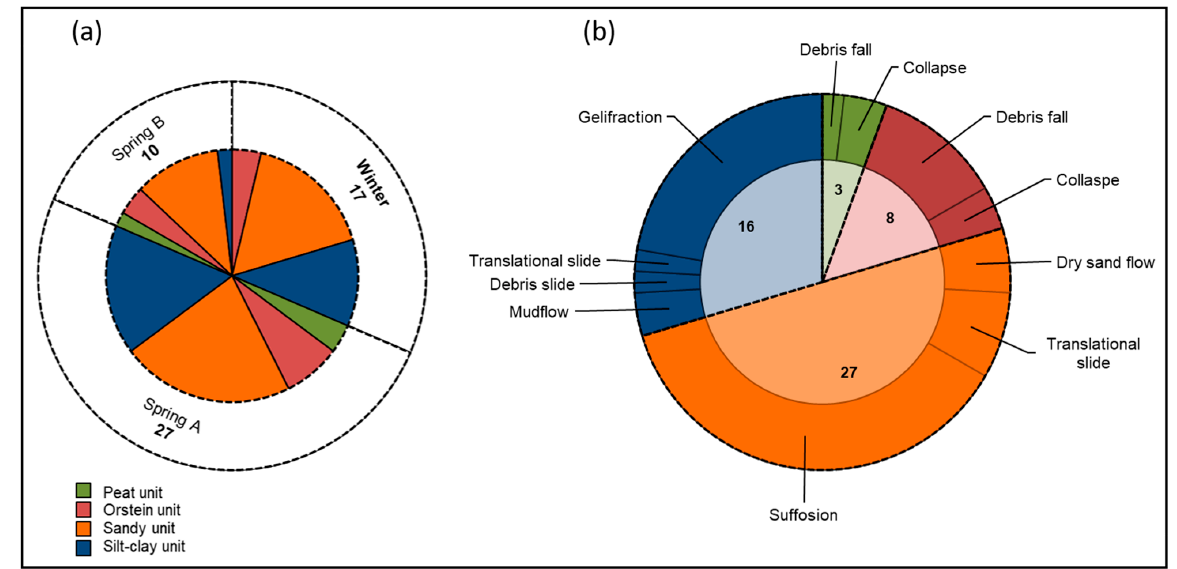
Figure 10. Number of events per lithological unit per season ( a ), and processes affecting the different lithologies in Zone D ( b ).